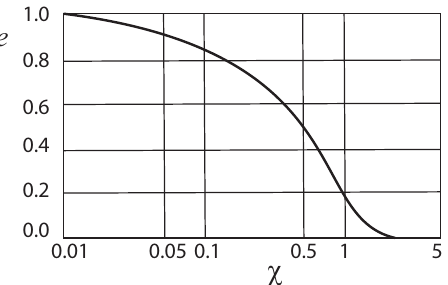
Figure 6. The relationship between χ and the coefficient of restitution e [54].